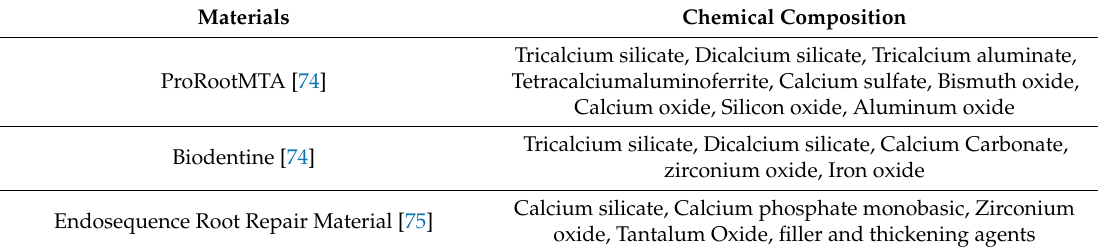
Table 1. The chemical composition of ProRoot mineral trioxide aggregate (MTA), Biodentine, and Endosequence Root Repair